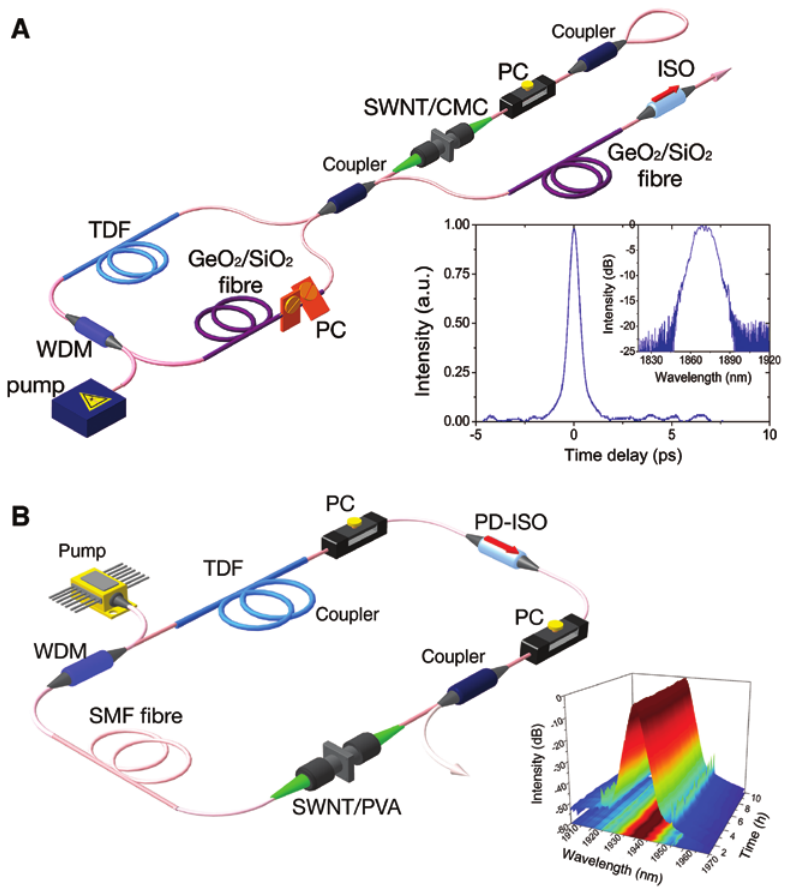
Figure 18: Configuration of the SWNT mode-locked Tm-doped fibre laser in (A) geometry, based on NALM; (B) ring configuration with NPE. TDF, Thulium-doped fibre; WDM, wavelength division multiplexor; PC, polarisation controller; GeO (polarization-dependent) isolator. Inset: Output pulse characteristics. Adapted from